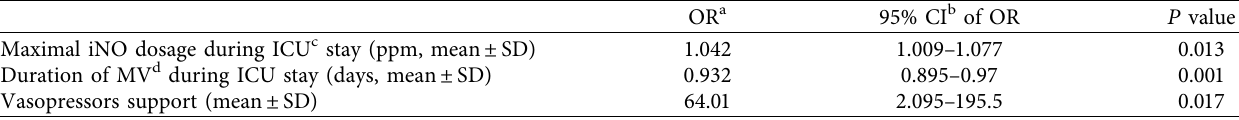
Table 4: Multivariate logistic regression analysis for risk factors for ICU mortality in critically ill patients with iNO